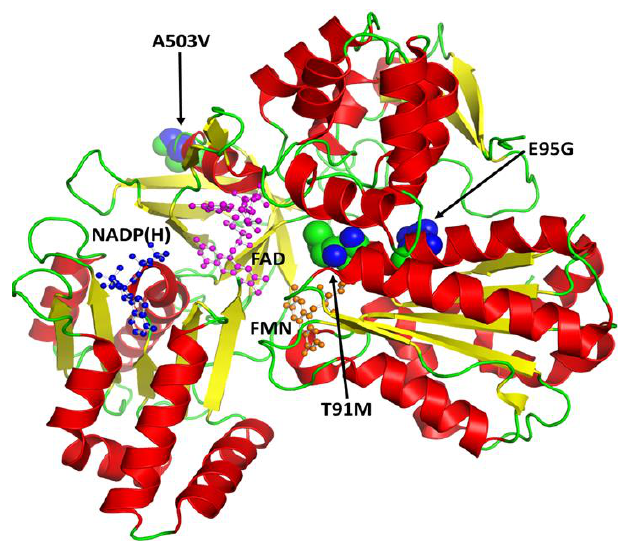
Figure 7. A secondary structural feature-based (helices in red, sheets in yellow and loops in green) schematic illustration of the human cytochrome P450 oxidoreductase (CYPOR). The co-factors FAD (magenta), NADP(H) (blue), and FMN (orange) are shown as ball and stick models. Missense mutations identified in the Pakistani population are shown as spheres.